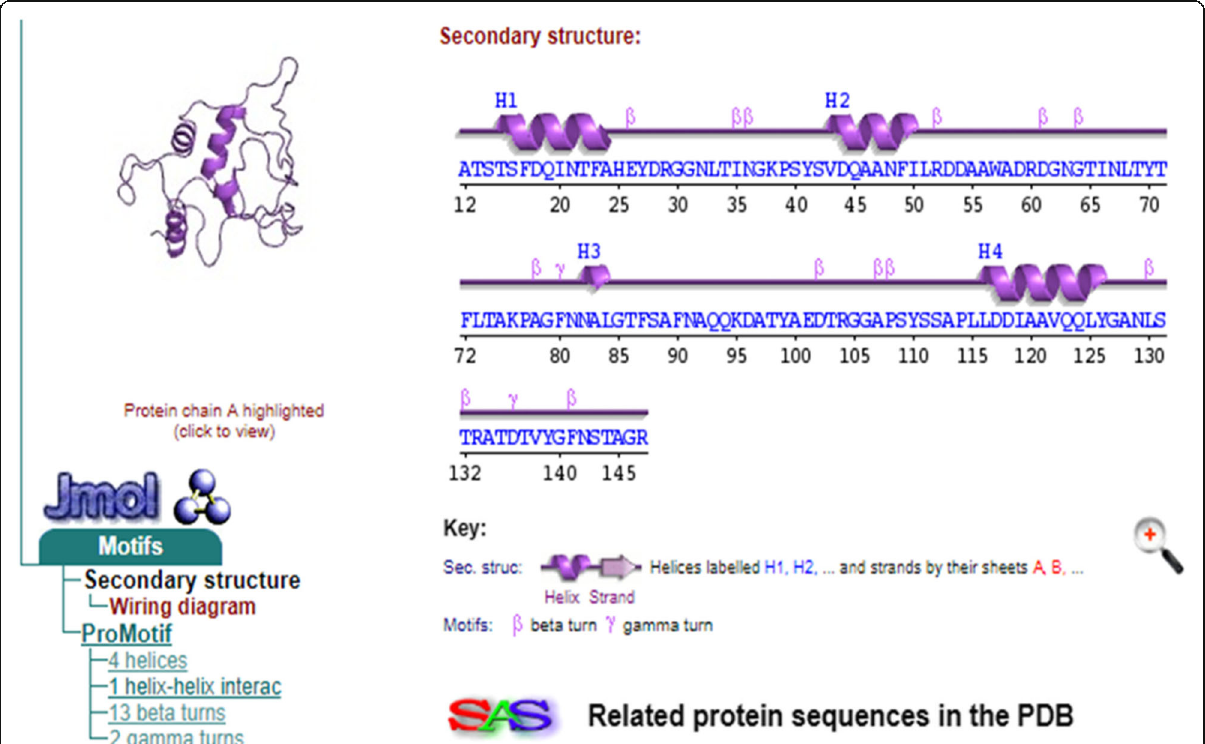
Fig. 16 Secondary structure of S.AMP13 by ProFunc server where α -helices are labeled with H; beta and gamma turns are labeled with β and γ